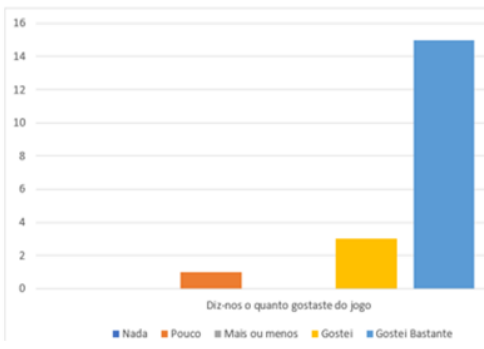
Figure 13. Results of the answers of the students to the question: How much did you like the game?